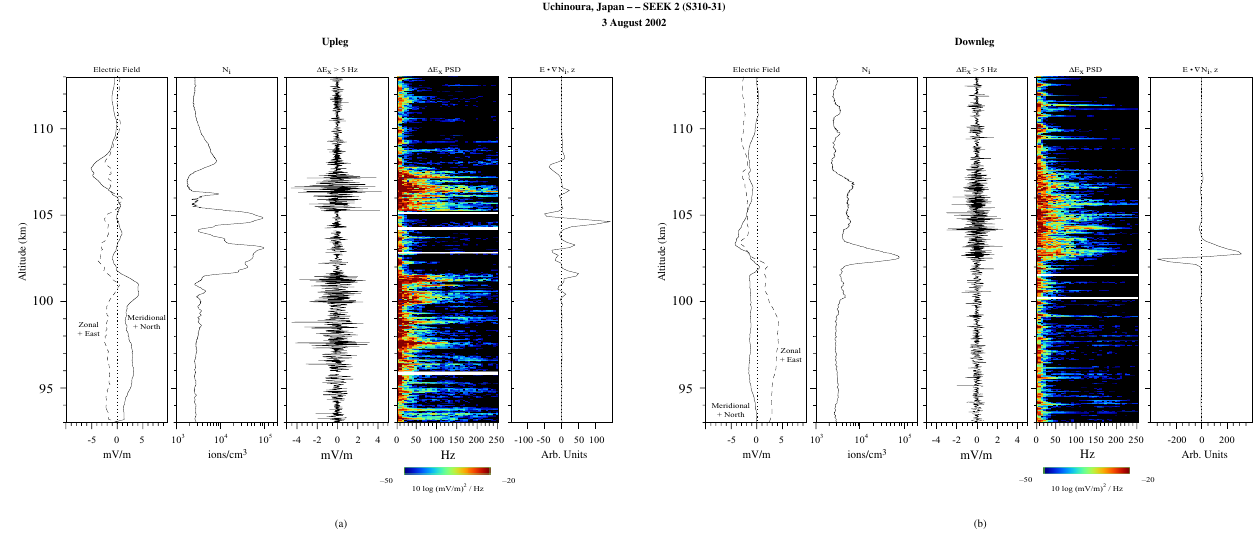
Fig. 13. (a) Expanded view of the upleg measurements in the sporadic- E region (93–113km). The panels show (from left to right) the DC electric field, plasma density, 1E x waveform for frequencies > 5Hz, 1E x spectrogram, and the scalar product of the DC electric field and the vertical gradient of the plasma number density. (b) Same as Fig. 13a but for the